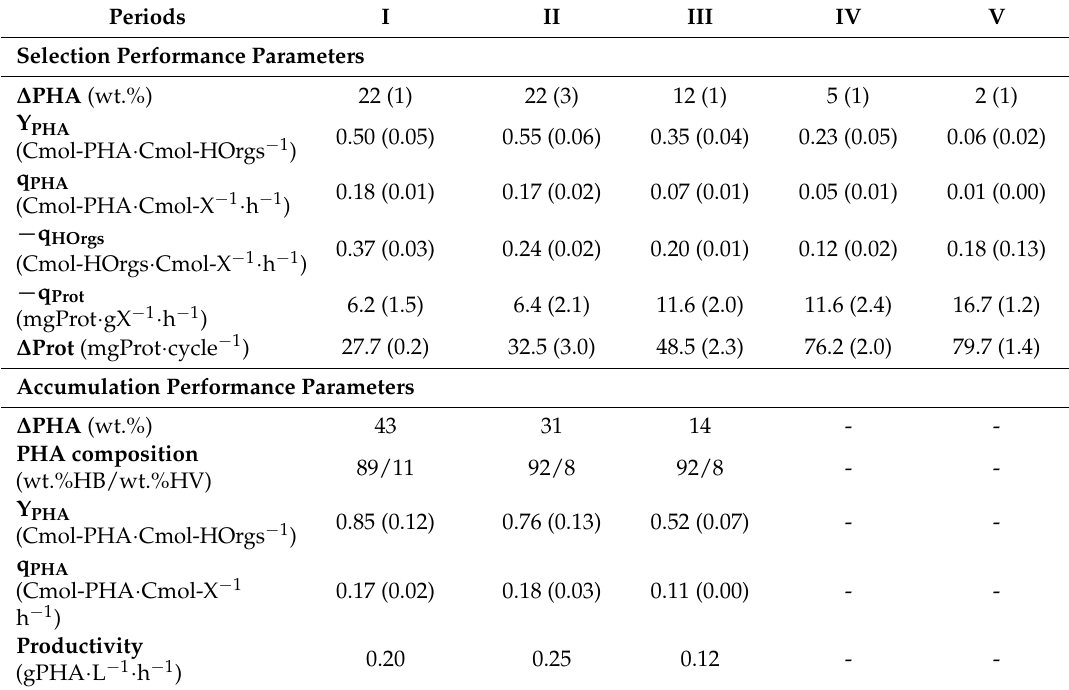
Table 3. The average performance of the enriched MMC in the selection reactor in the five different periods (I–V); and an overview of the PHA-accumulation assays with the MMC selected on Periods I, II, and